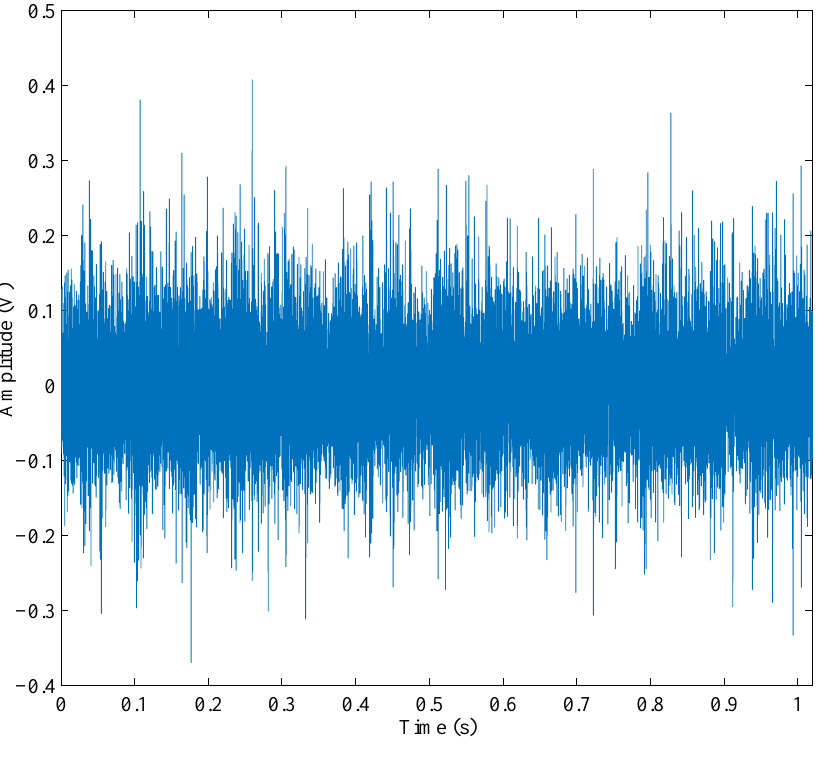
Figure 6. The reconstructed signals with eligible IMFs.